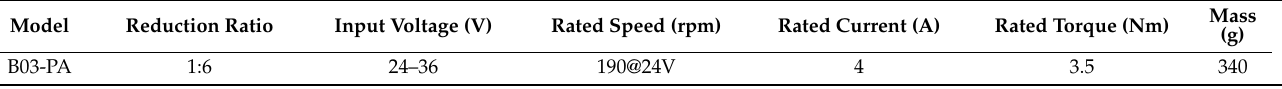
Table 2. Actuator